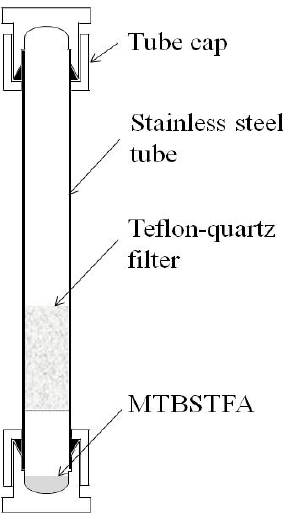
Fig. 11. Particulate-phase MTBSTFA derivatisation scheme.